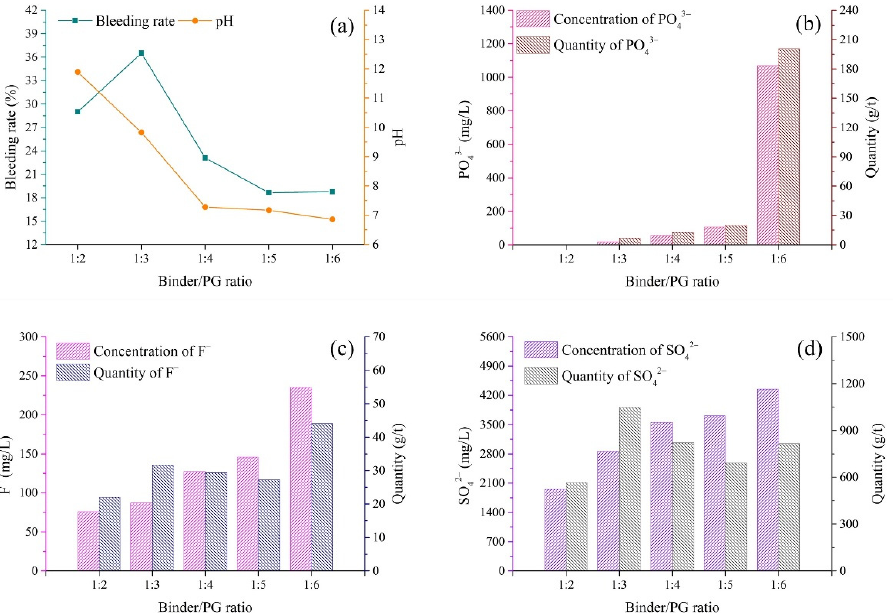
Figure 5. Variations in bleeding rate, pH and pollutants in bleeding water according to different binder/PG ratios of backfill slurry. ( a ) Bleeding rate and pH; ( b ) PO 43 − ; ( c ) F − ; ( d ) SO 42 −